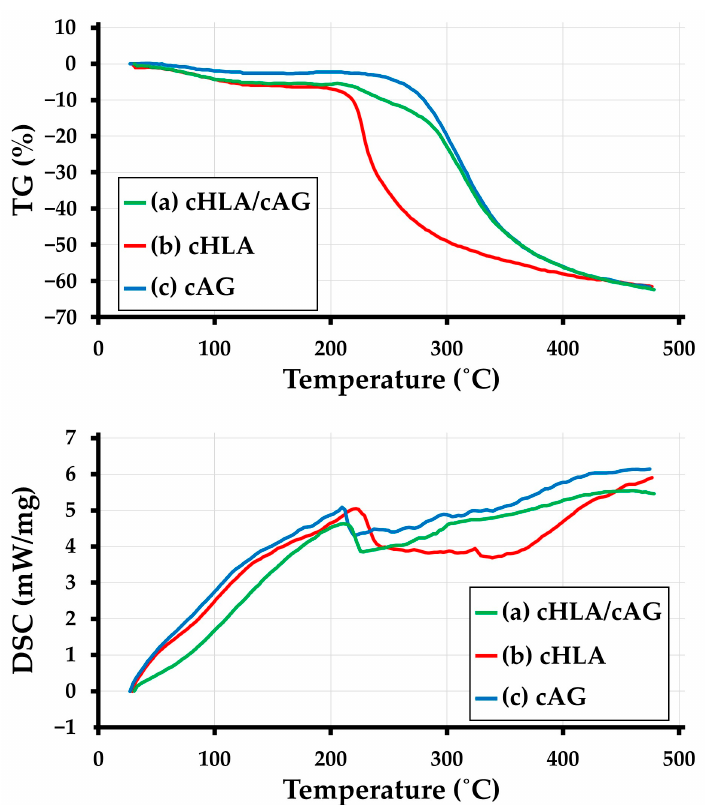
Figure 3. Thermogravimetry ( TG) (Top) and differential scanning calorimetry (DSC) (bottom) thermal analyses results of ( a ) cHLA/cAG, ( b ) cHLA, and ( c ) cAG.